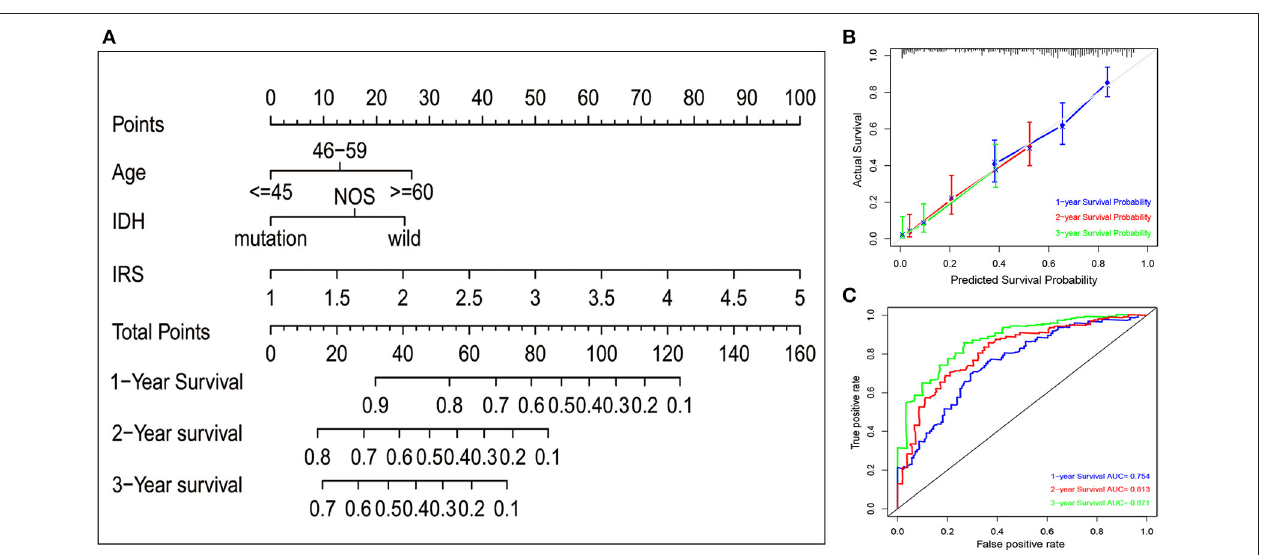
FIGURE 2 | Nomogram construction in TCGA set. (A) A nomogram to quantitatively predict 1-, 2-, and 3-year survival for GBM patients based on IRS, clinical and molecular parameters. (B) Calibration curves of the nomogram for showing the consistency between predicted and actual survival. (C) A series of time-dependent ROC curves for assessing the performance of the prediction